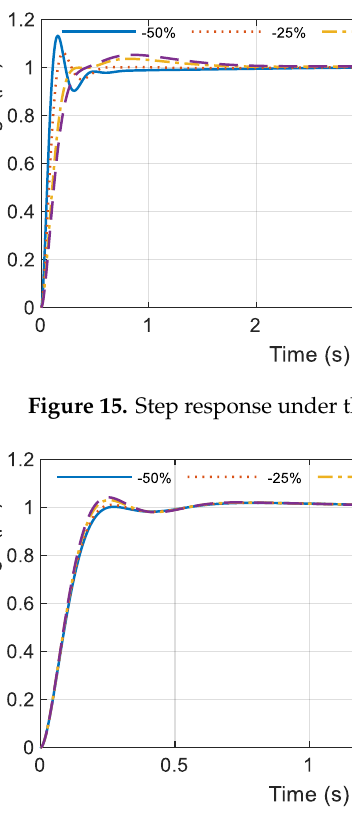
Figure 14. Step response under the variation of T E.